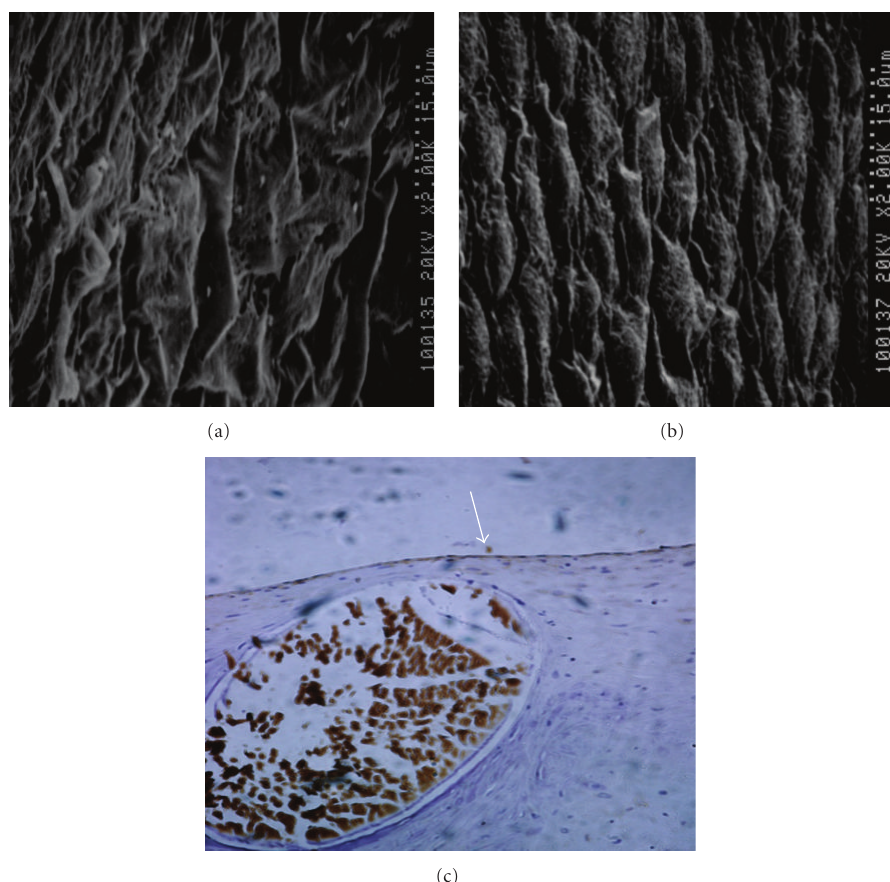
Figure 6: Endothelialization of of the surface of occlude. (a) Eight weeks after the procedure, the surface of occluder was lined with a layer of sparse endothelial cells (scanning electron micrographs × 2,000); (b) paving-stone-like arranged endothelial cells cover completely the surfaces of devices at 12 weeks (scanning electron micrographs × 2,000); (c) positive immunohistochemical staining (white arrow) for CD34 in superficial cells of the neointima at 12 weeks after implantation (original magnification 10 ×